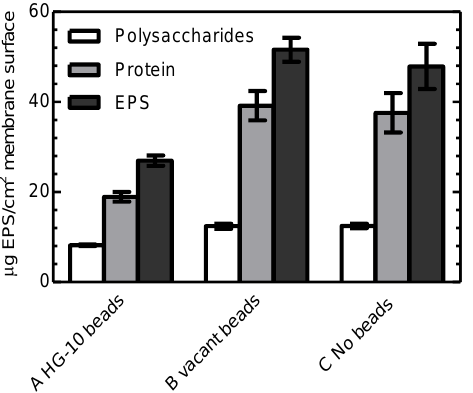
Figure 2. The amount of extracellular polymeric substances (EPS) on the surface of the polyvinyl difluoride (PVDF) membrane on the eighth day. Error bars represent standard deviations ( n = 3).